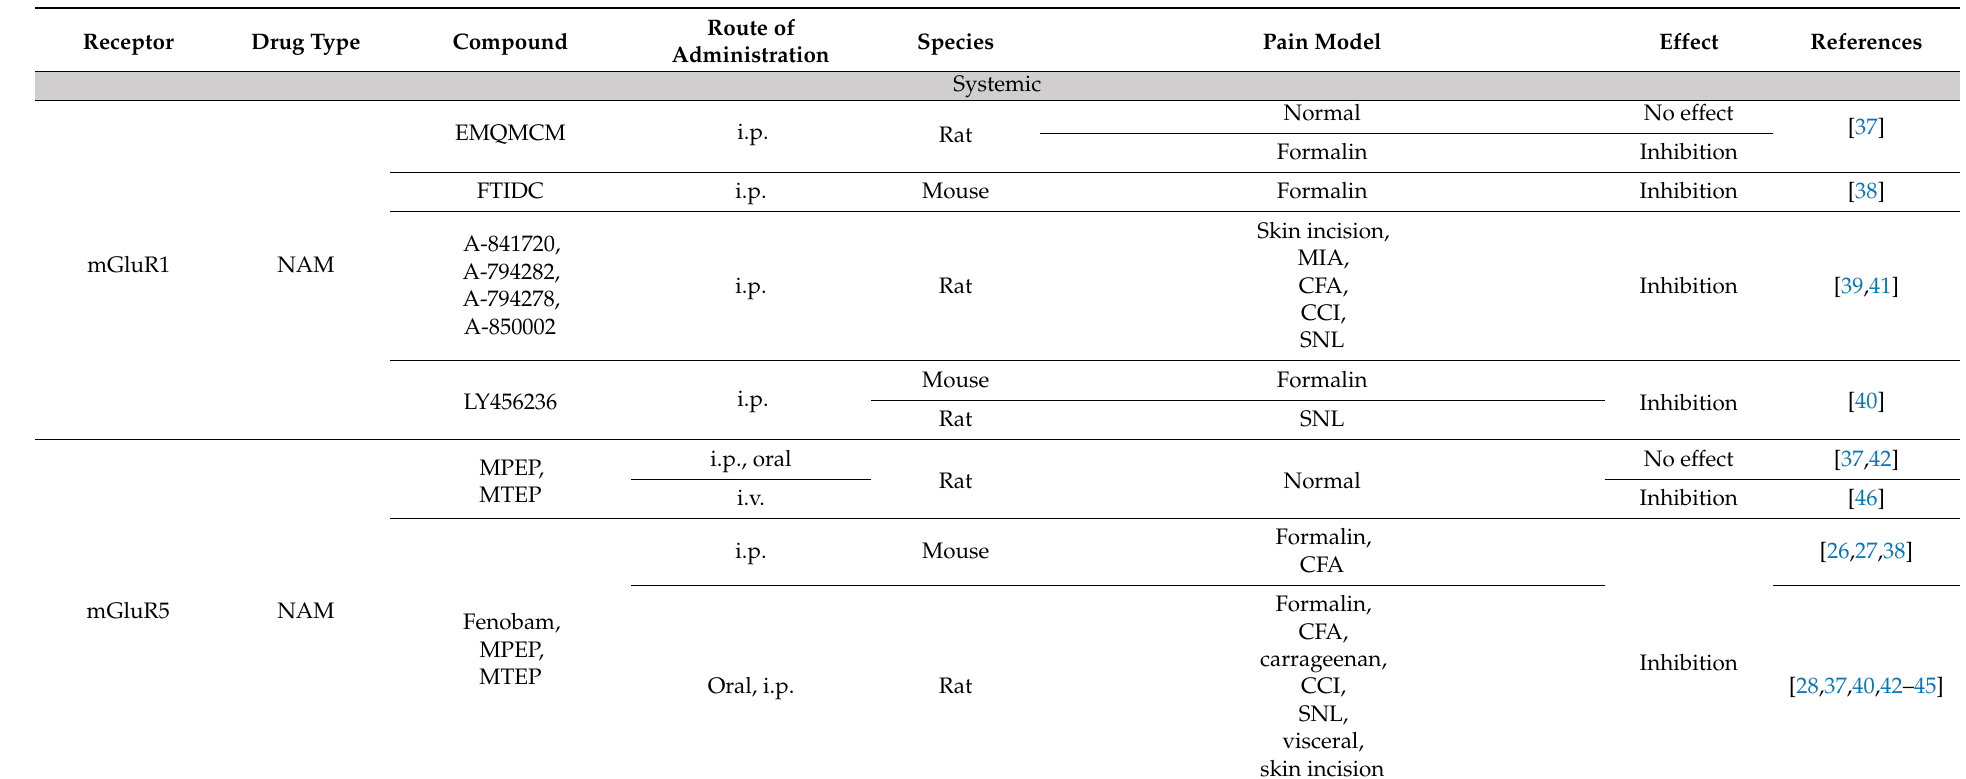
Table 1. Behavioral effects of group I mGluR drugs in preclinical pain